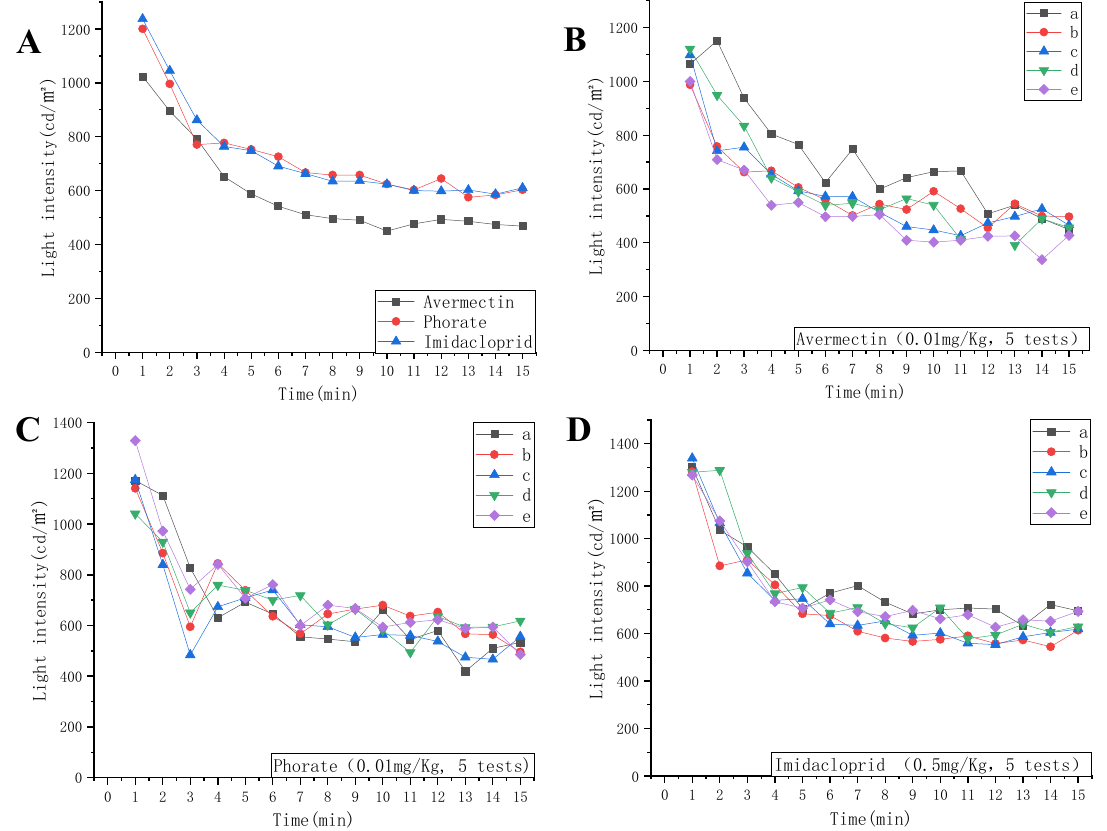
Figure 1. The light intensity change model of the three pesticides. ( A ) The average light intensity (wavelength: 611.59 nm) of each min by the 9 proposed test chips during a period of 15 min, with a concentratiom of 0.5 mg / Kg in the imidaloprid sample and 0.01 mg / Kg for the phorate and avermectin samples. ( B ) The light intensity of each min for 5 competitive tests using the proposed chip for 0.01 mg / Kg of avermectin, ( C ) 0.01 mg / Kg of avermectin, and ( D ) 0.5 mg / Kg of imidaloprid. Each color line records the reflected light intensity of each minute by one chip, and all of the five chips (lines) in each figure are tested by the same concentration demonstrated at the bottom of the figure.